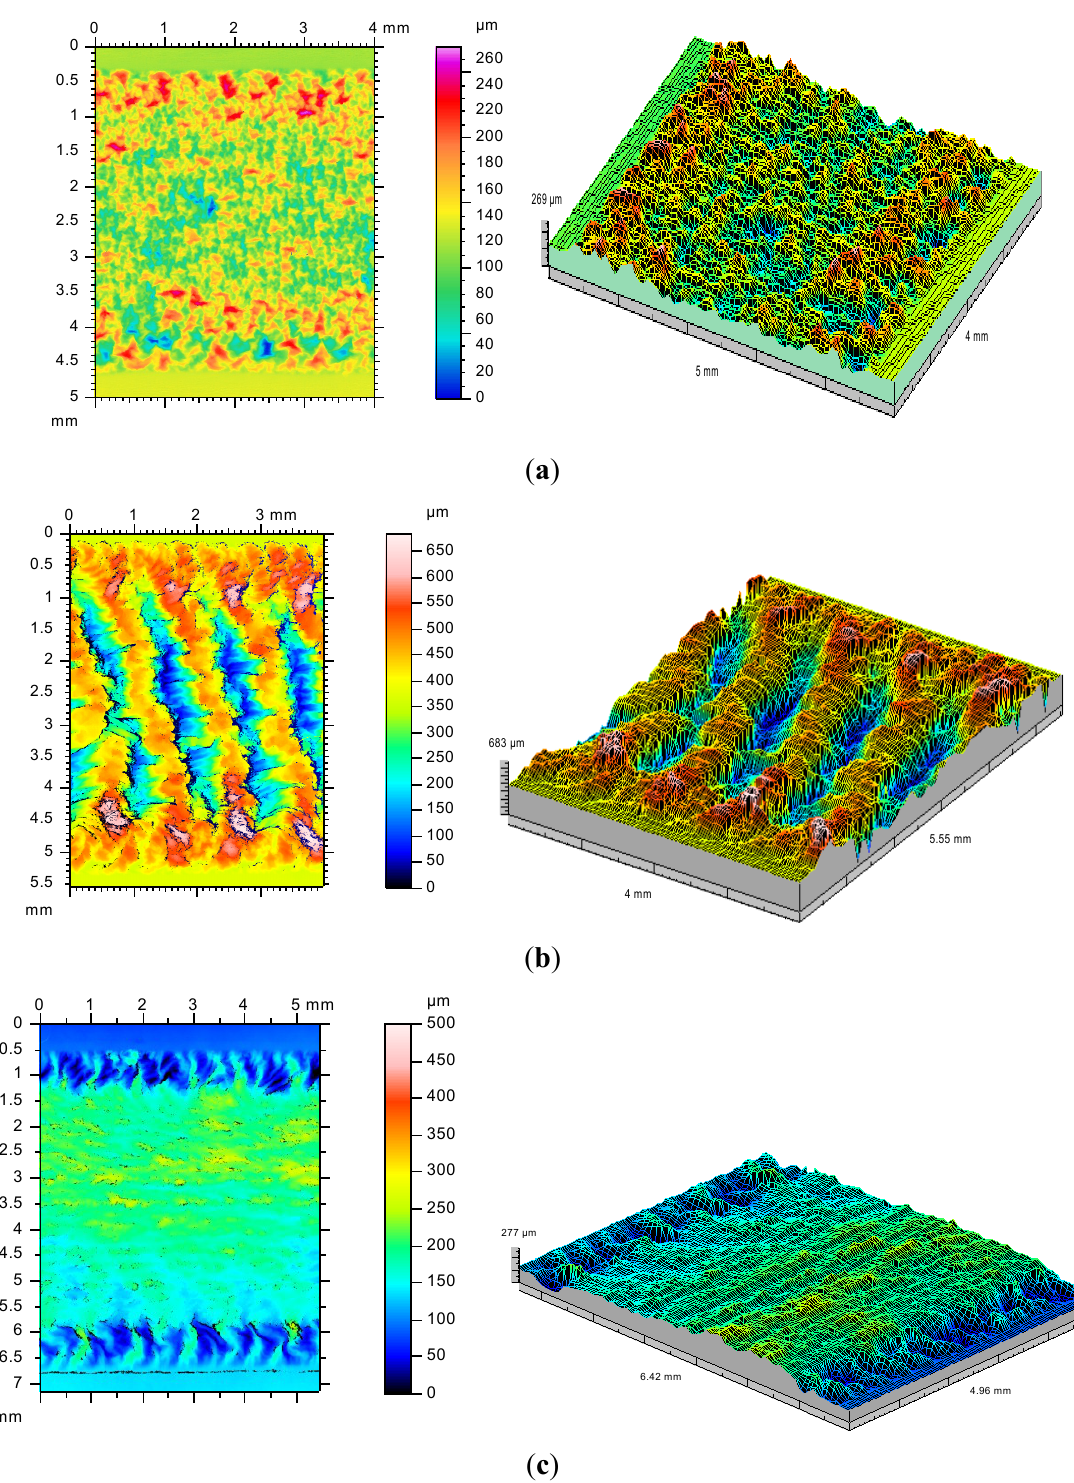
Figure 8. 2D and 3D topography of the surface layers produced on titanium alloy Ti6Al4V by HPDDL laser gas nitriding (Tables 2 and 3); ( a ) sample No. P20; ( b ) sample No. P12; ( c ) sample No.